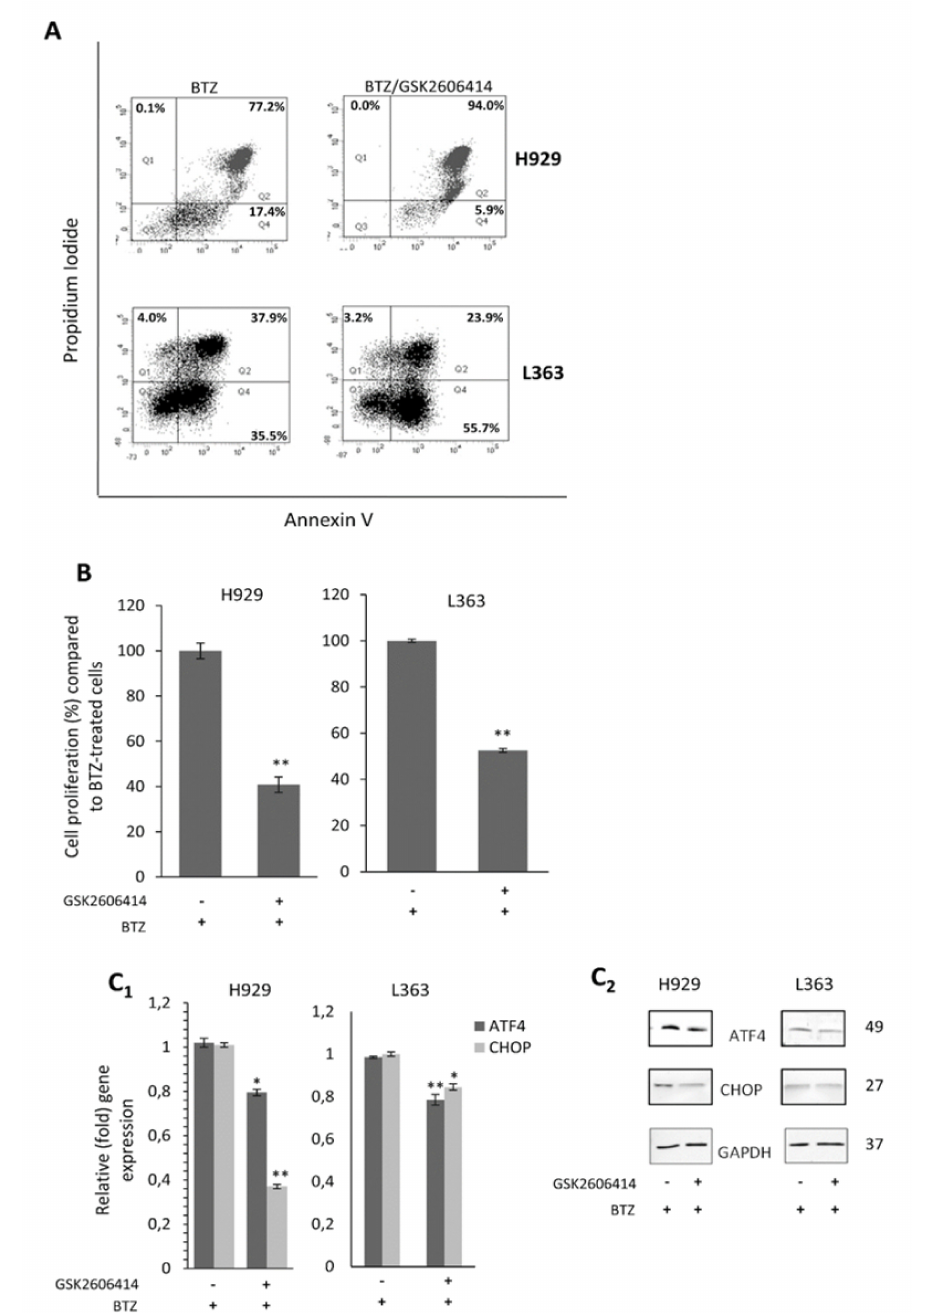
Figure 6. ( A ) Annexin V–PI staining of H929 and L363 cells exposed to bortezomib (BTZ; 4 nM) for 24 h with or without GSK2606414 (10 µ M) treatment for 48 h; to set up compensation and quadrants, unstained cells, cells stained only with Annexin V and cells stained only with PI were used as controls. ( B ) % Cell survival of H929 and L363 cells subjected to BTZ (4 nM) for 24 h with or without GSK2606414 (10 µ M) treatment for 48 h. ( C 1 ) Q-PCR expression analyses of ATF4 and CHOP mRNA expression levels in H929 and L363 cells before and after incubation with BTZ (4 nM) for 24 h in the presence (or not) of GSK2606414 (10 µ M) for 48 h. ( C 2 ) Representative immunoblotting analyses of protein samples probed with antibodies against ATF4 and CHOP. GAPDH probing and β -ACTIN mRNA expression were used as references for total protein and mRNA input, respectively. The uncropped Western Blot figure is shown in Figure S4E. Means ± SDs from three replicates are shown. *, p < 0.05; **, p <